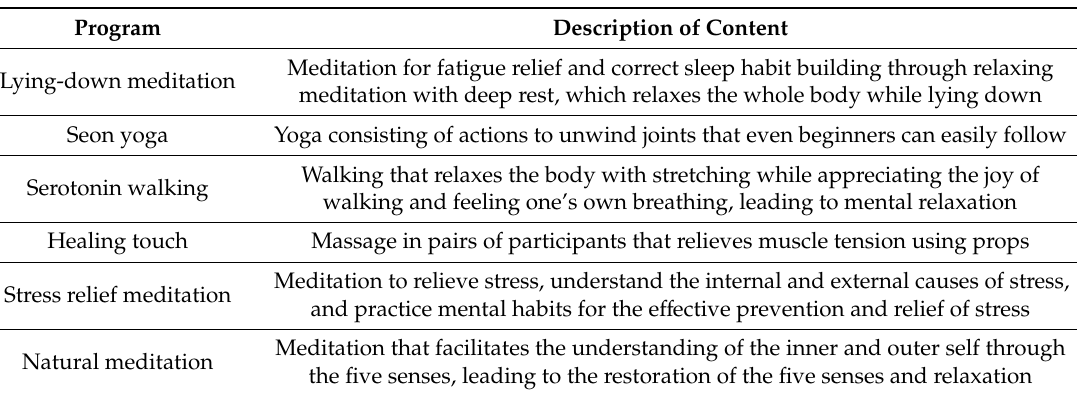
Table 1. List of items in the developed forest therapy program.